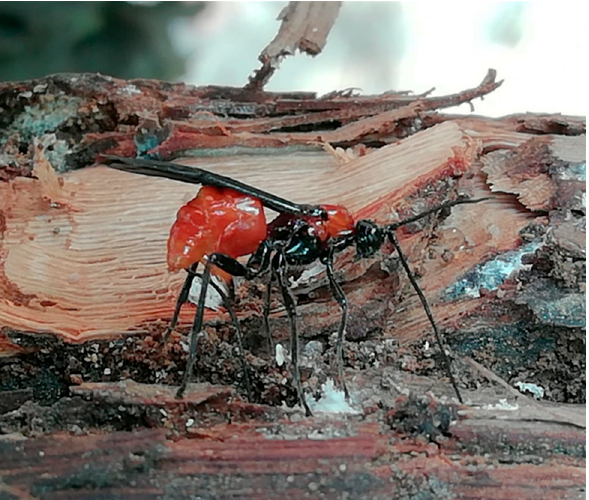
Figure 7. A Digonogastra sp. ovipositing through the bark of a Givira ethela infested vine (Clovis site, August